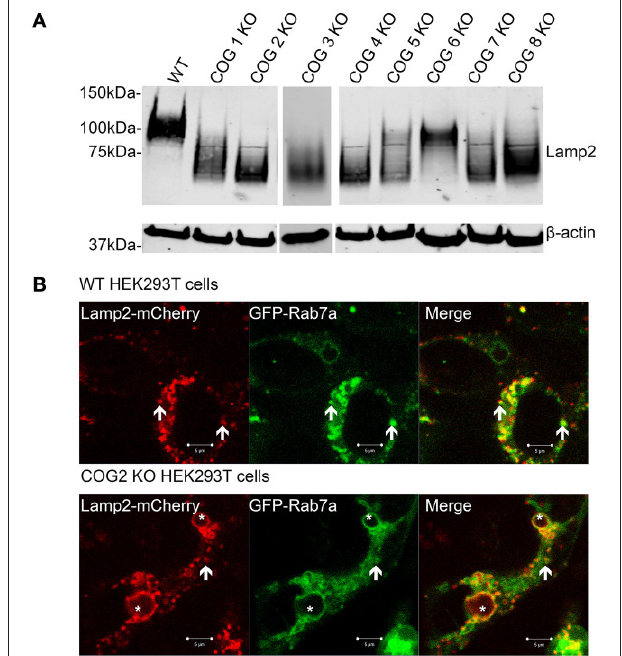
FIGURE 9 | Lamp2 is hypoglycosylated in COG subunit KO cells, but still localizes to lysosome like structures. (A) Cell lysates were analyzed by western blot for Lamp2 mobility. (B) WT and COG 2 KO cells were transfected with Lamp2-mCherry and GFP-Rab7a. Arrows represent colocalization. Asterisks represent large, late endocytic inclusions. Images taken of live